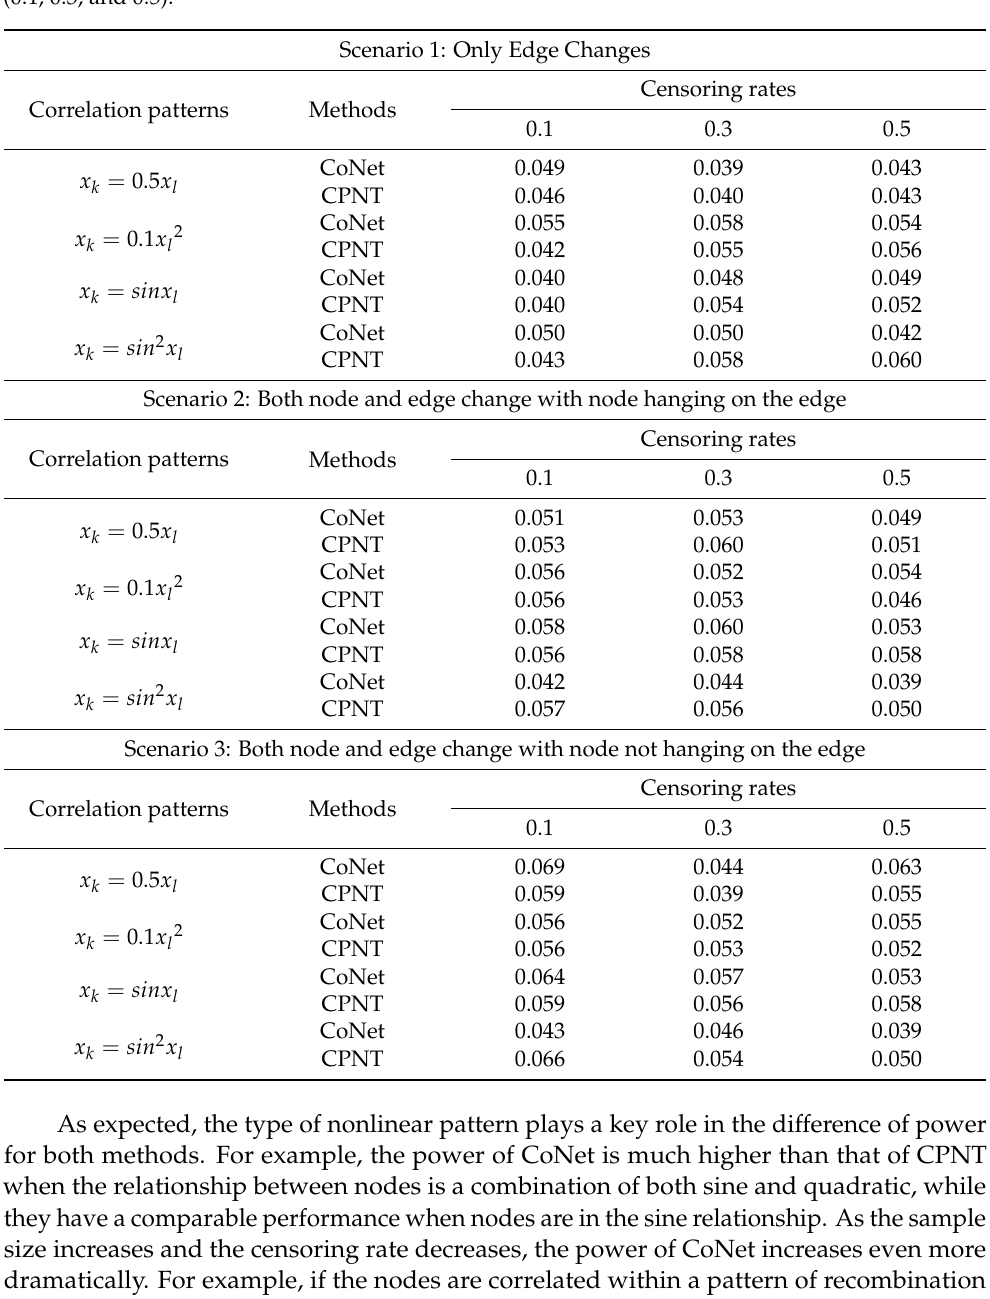
Table 3. The type I error for testing the effect of the edge on the survival phenotype under three scenarios where the effecting edge is pre-specified ( n = 5000), with the SNP effect obtained from DPR model. Simulations were conducted with four different between-node correlation patterns (the combination of sine and quadratic, sine, quadratic, and linear) and three different censoring rates (0.1, 0.3, and